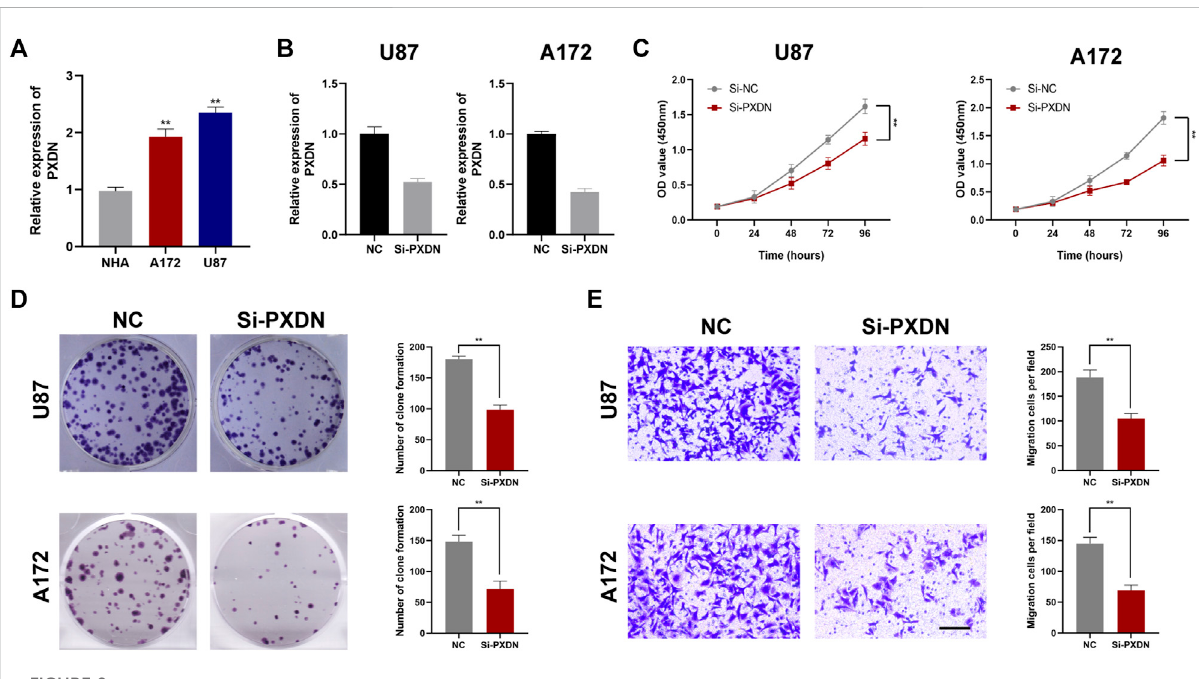
FIGURE 9 SilencingofPXDNblockedGBMcellproliferation. (A) ThemRNAexpressionlevelofPXDNinNHAandGBMcelllines. (B) qRT-PCRtoassessthe silencing effect of PXDN after siRNA transfection. (C,D) The effect of PXDN on proliferation in U87 and A172 was examined using CCK-8 assay and clone formation. (E) The role of PXDN on migration in U87 and A172 was detected by tranwell